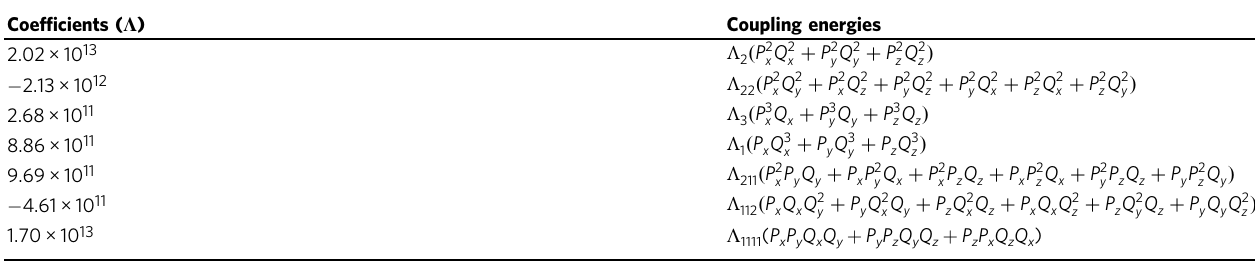
Table 1 On-site couplings between ferroelectric soft mode P and high-frequency auxiliary mode Q. Coef fi cients ( Λ )